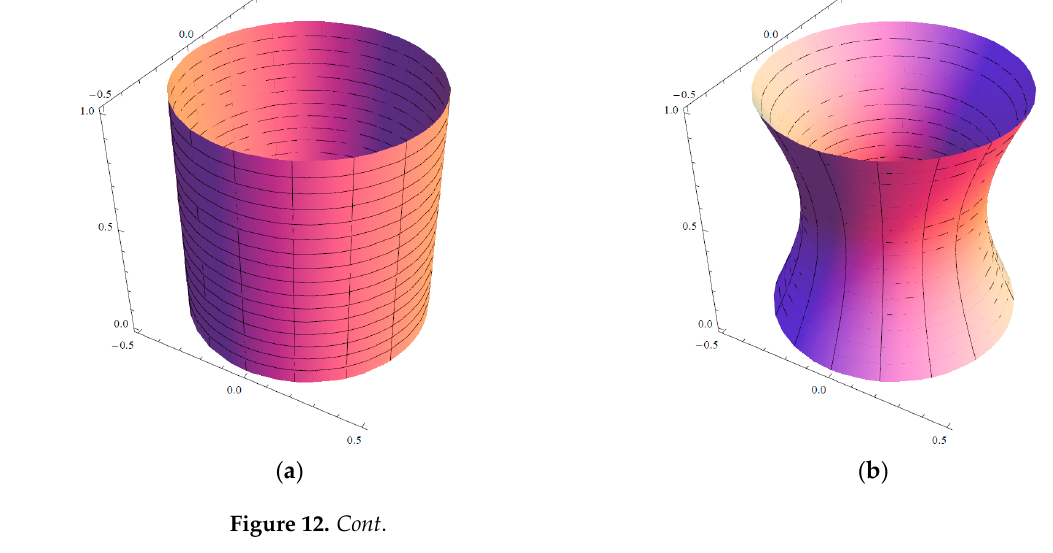
( f ) Figure 12. Mode shapes of the simply supported SWNT of Table 1 with chirality indices (𝑛 = 5,𝑚 = 5) and aspect ratio 𝐿/𝑅 = 10 : ( a ) Radial breathing mode (𝑞 = 0,𝑠 = 0) ; ( b ) axisymmetric mode (𝑞 = 1,𝑠 = 0) ; ( c ) beam-like mode (𝑞 = 1,𝑠 = 1) ; ( d ) shell-like mode (𝑞 = 1,𝑠 = 2) ; ( e ) shell-like mode (𝑞 = 1,𝑠 = 3) ; and ( f ) shell-like mode (𝑞 = 1,𝑠 = 4) .